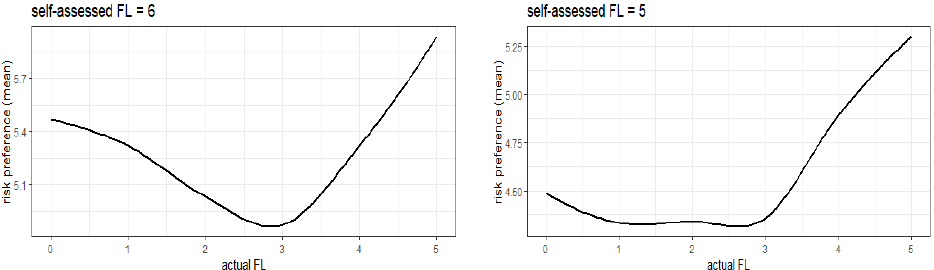
Figure 2. Plots of mean risk preference against actual financial literacy at given self-assessed literacy.